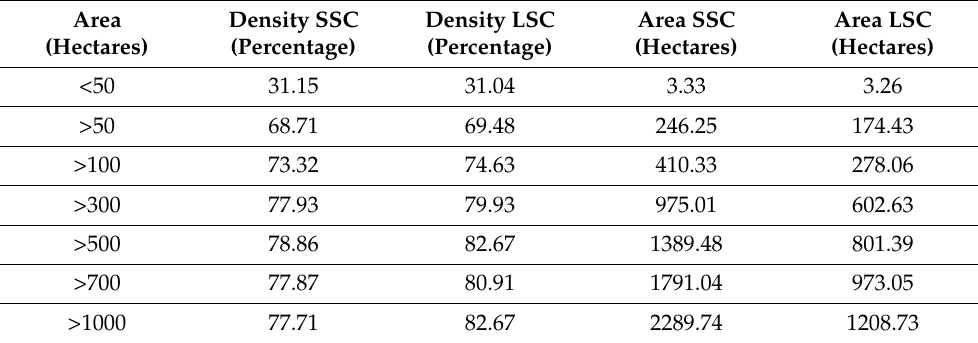
Table 3. Density of patches in SSC and LSC.